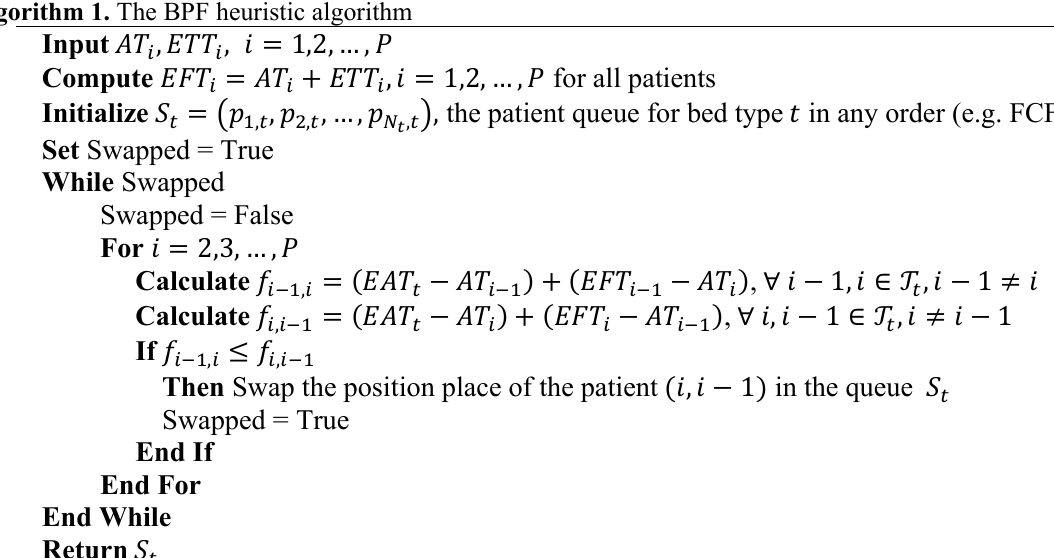
Algorithm 1. The BPF heuristic